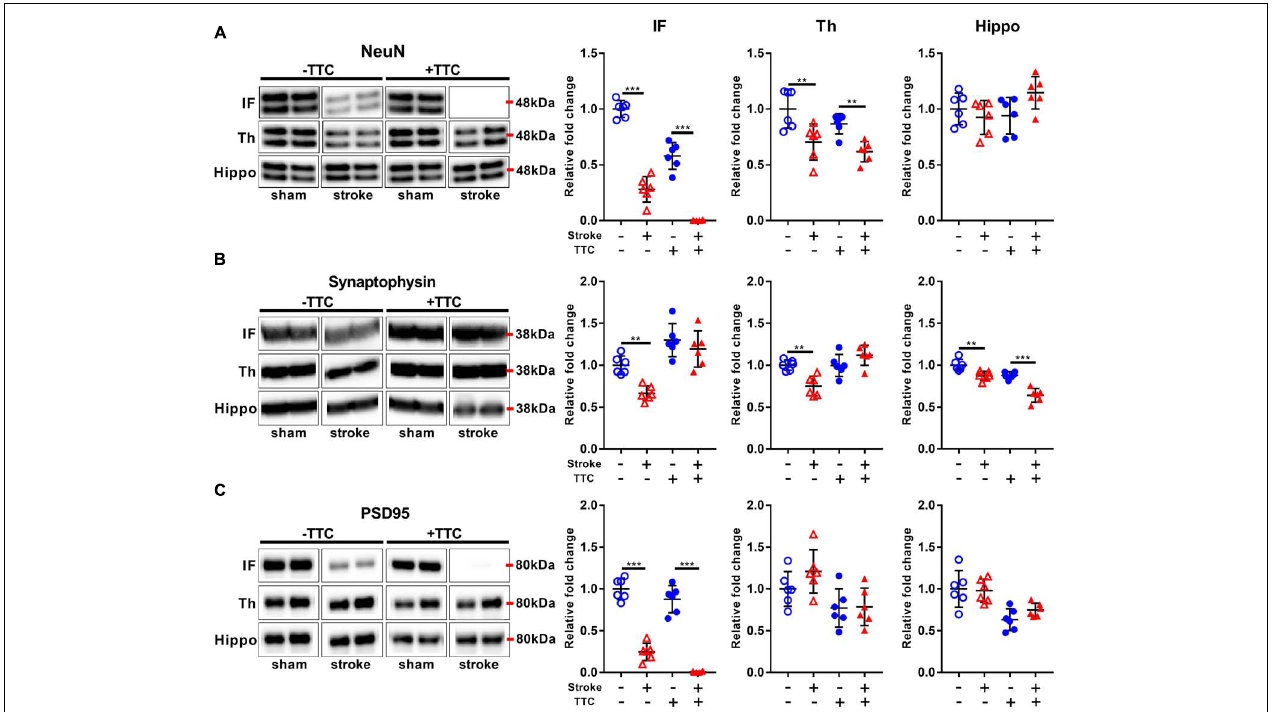
FIGURE 3 | Neuronal markers. Representative western blot and quantification of NeuN (A) Synaptophysin (B) , and PSD95 (C) within the infarct (IF), thalamus (Th), and hippocampus (Hippo). Mean ± SEM (two-way ANOVA and Sidak’s multiple comparisons).